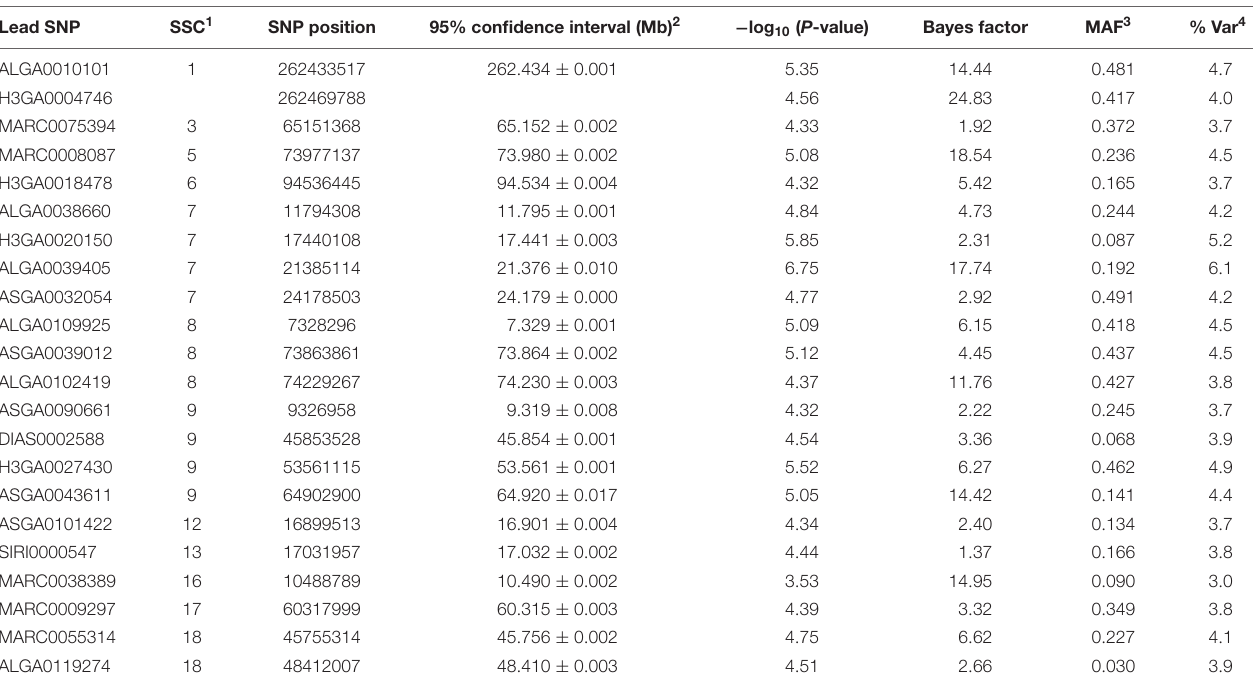
TABLE 6 | Genomic regions and corresponding lead SNPs identified by single- and multi-locus GWAS for serum ALP. Lead SNP SSC